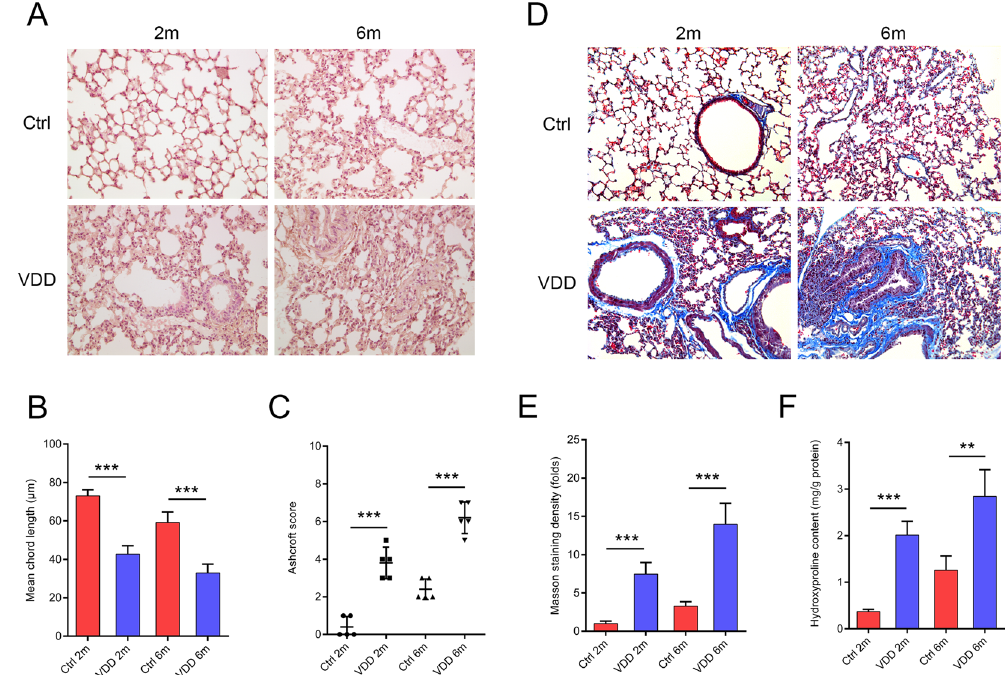
Figure 1. Chronic vitamin D deficiency results in structural damage and increased lung fibrosis, which aggravates with time. ( A ) Haematoxylin and eosin staining of the lung tissue after two months and six months of vitamin D deficiency. Original magnification: 200 × . ( B ) Mean chord length of the lungs. *** P < 0.001 Ctrl versus VDD group of the same age (n = 10 in each group). Significant difference existed between Ctrl 2 m group and Ctrl 6 m group ( P < 0.001). ( C ) Microscopic scoring of the lung tissue according to Ashcroft. *** P < 0.001 Ctrl versus VDD group of the same age (n = 5 in each group). Significant difference existed between Ctrl 2 m group and Ctrl 6 m group ( P < 0.001). ( D , E ) Masson staining and the quantification of collagen